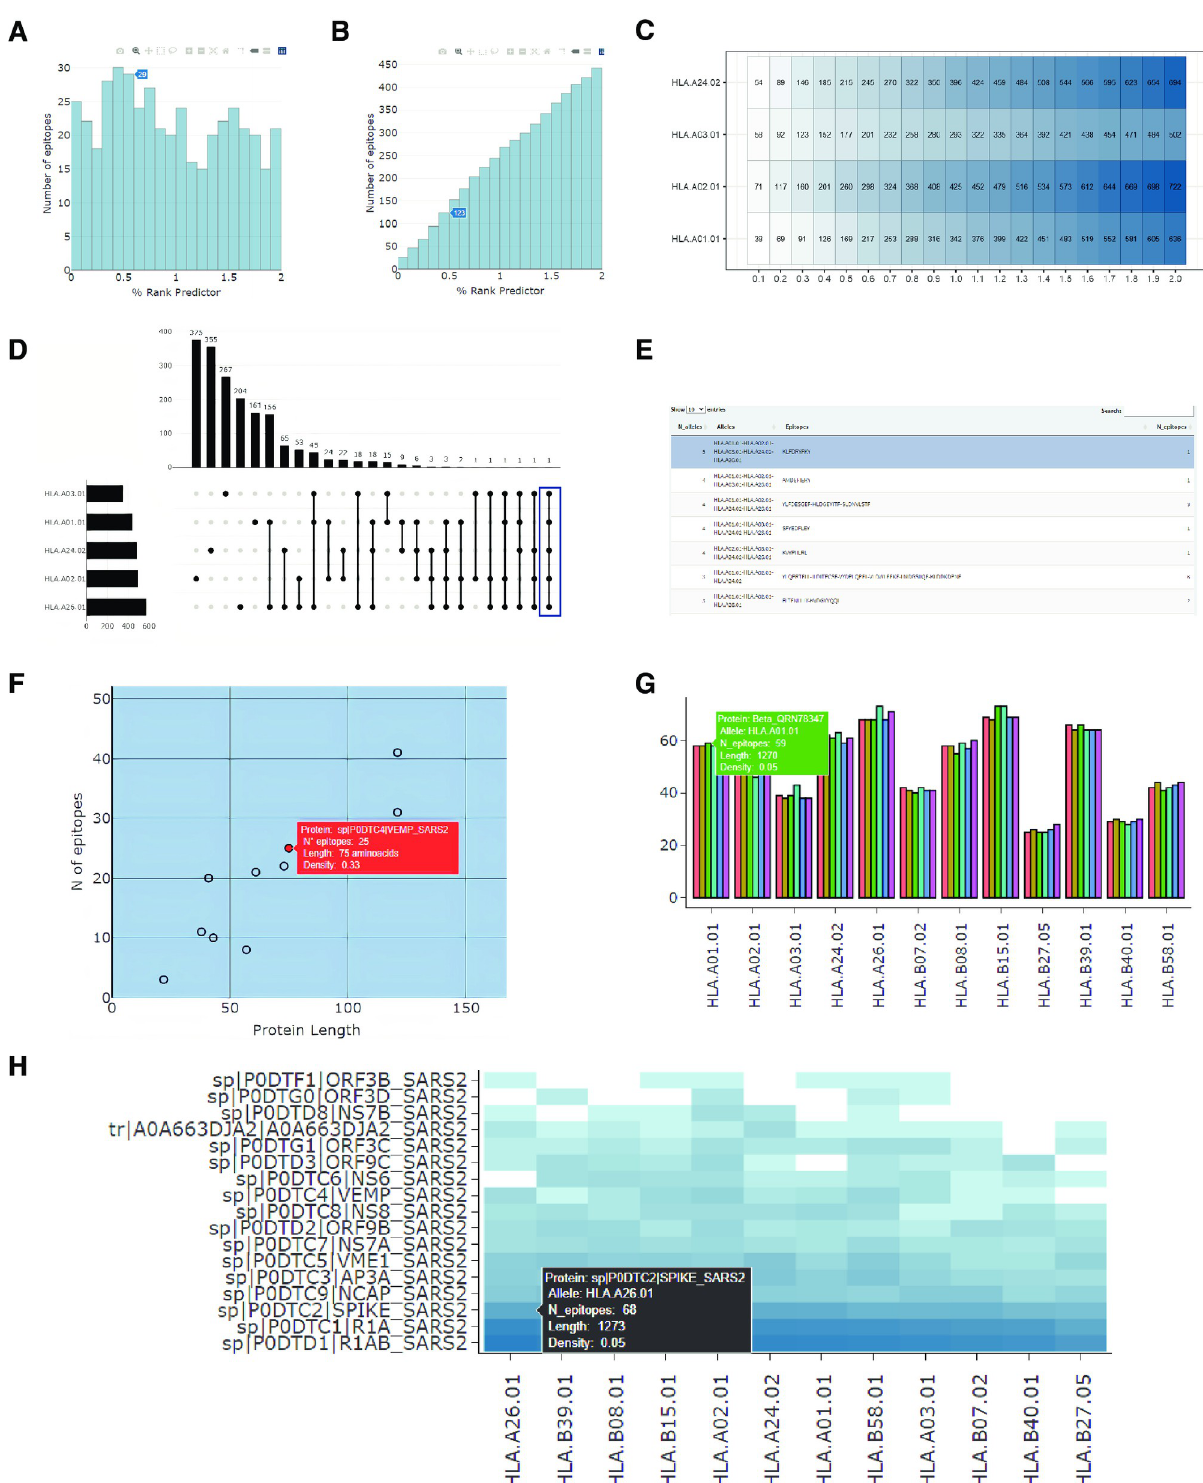
Fig 2. Outputs of the ‘Epitope Distribution’, ‘Epitope Intersection’, and ‘Epitope Density’ tools. Plots produced using the ( A-C ) ‘Epitope Distribution’, ( D, E ) ‘Epitope Intersection’, and ( F-H ) ‘Epitope Density’ tools. (A) Histogram showing the number of epitopes within a particular range of percentage rank. (B) The cumulative histogram shows the number of epitopes with a percentage rank lower than a specified value. Hovering over any of the columns shows the corresponding number of epitopes. (C) The number of epitopes predicted to bind to each MHC allele considering different